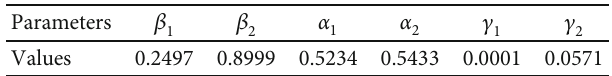
Figure 4: Validation of the Agree-Disagree model with the poll results data until the 50th week. Table 3: Estimated parameters value for models (1)-(3) for the fi rst